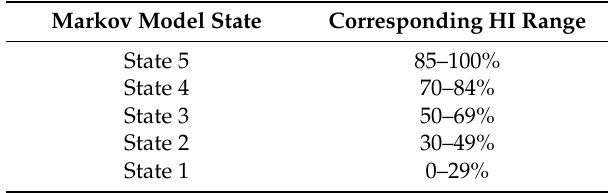
Table 3. Classification of transformer states based on health index.